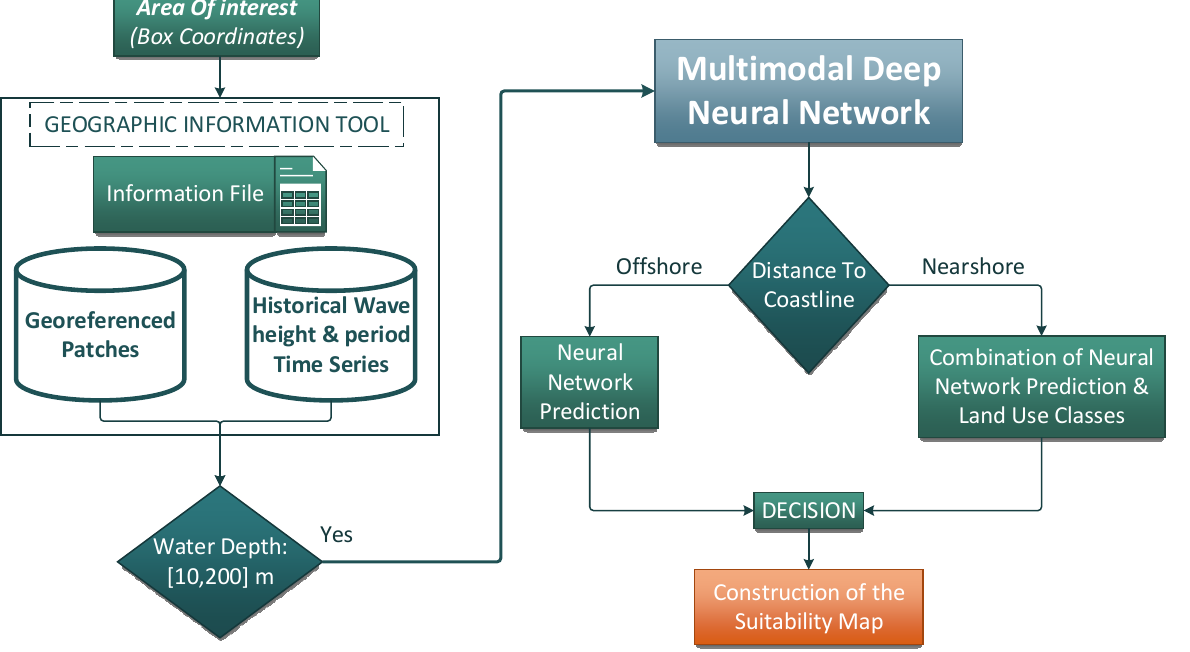
Figure 6. Decision-making system flowchart in Mode I.